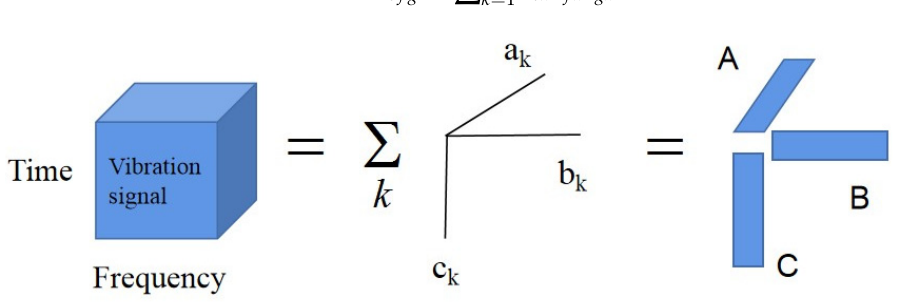
Figure 1. PARAFAC Decomposition Model a ek , b fk and c gk